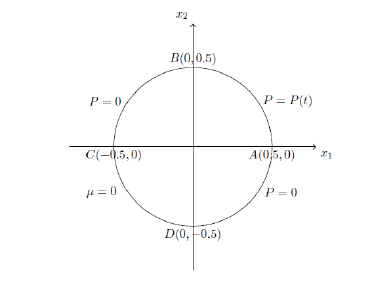
Figure 8. The boundary conditions for Problem 2.